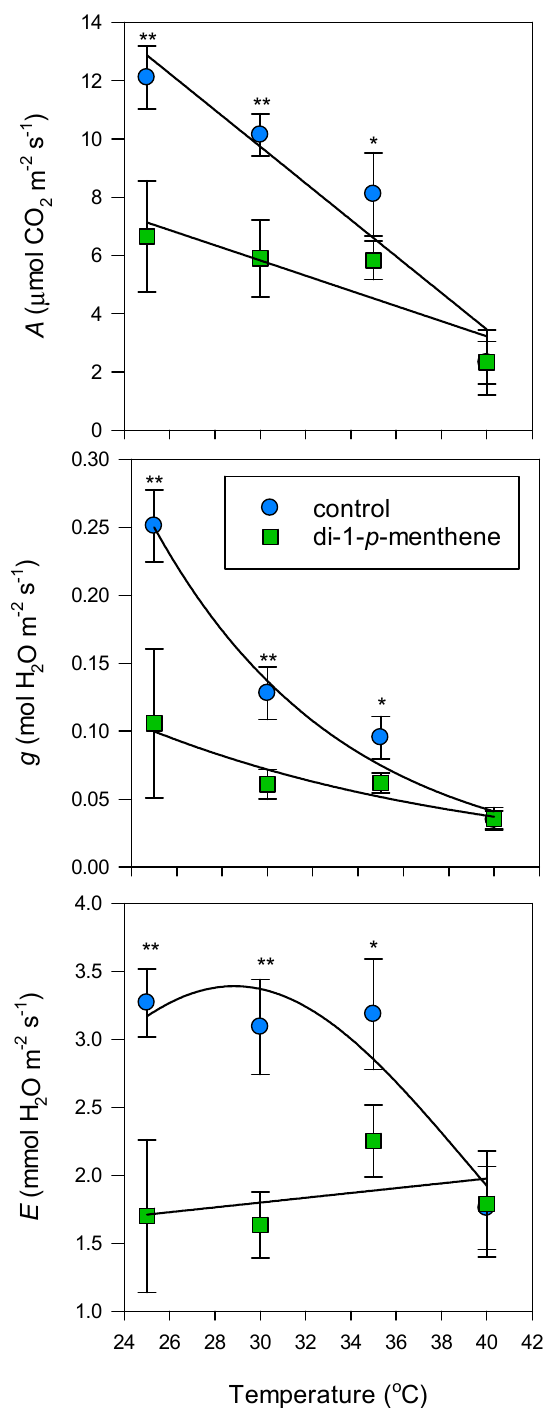
Figure 3. ‘’Tulameen’’ raspberry leaf net assimilation ( A ), stomatal conductance ( g ) and transpiration ( E ) in response to temperature following treatment with 1% di-1- p -menthene. Control leaves were treated with dH 2 O only. Leaf gas exchange was monitored 48 h after application. The light intensity of the IRGA leaf chamber was set to 1500 μ mol m − 2 s − 1 and the block temperature was increased at 5 °C intervals from 25 to 40 °C. Data are expressed as means ± s.e.m., n = 5, * p < 0.05, ** p < 0.01.